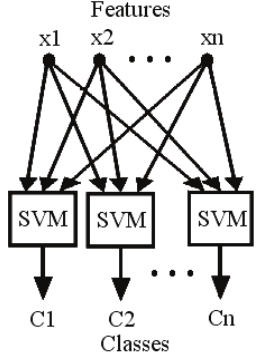
Figure 4. Structure of the SVM classifier